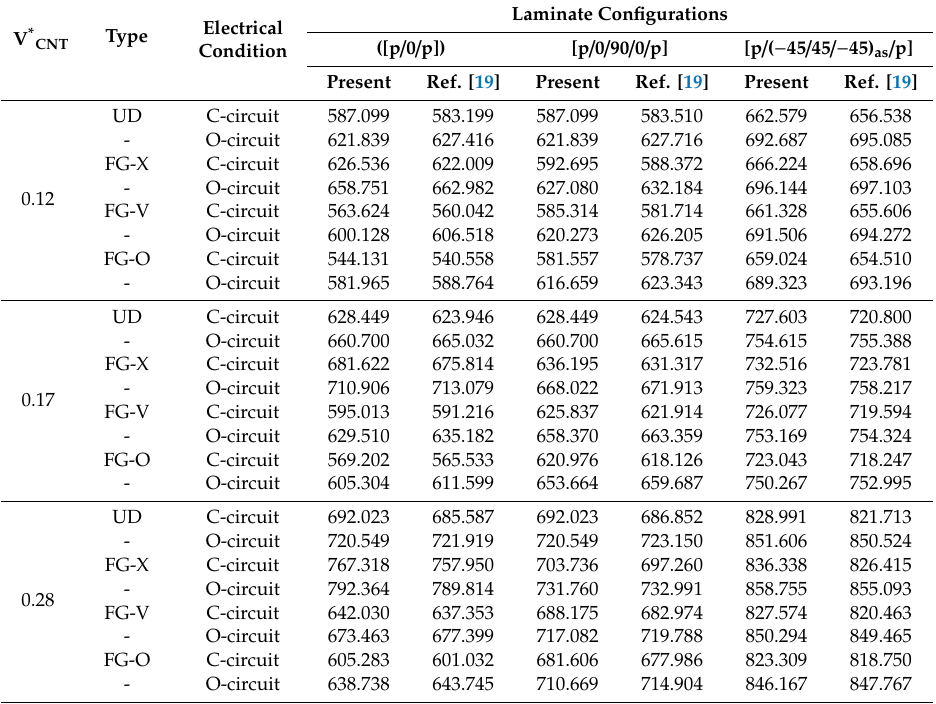
Table7. Thefundamentalnaturalfrequency(Hz)oftheSSSSsquarepiezoelectriclaminatedpiezoelectric functionally graded carbon nanotube-reinforced composite plates (PFG-CNTRC) ( a = b = 0.4 m; h p = 0.1 h ; a / h =